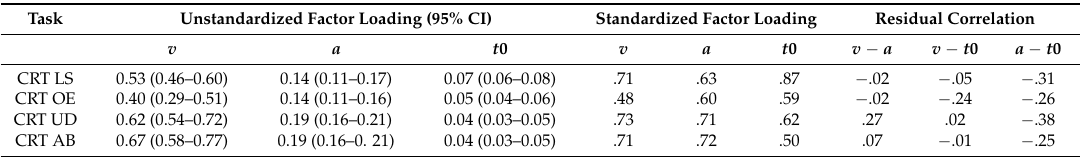
Table 3. Factor loadings and residual correlations from the confirmatory factor analysis with the parameters of Ratcliff’s Diffusion Decision